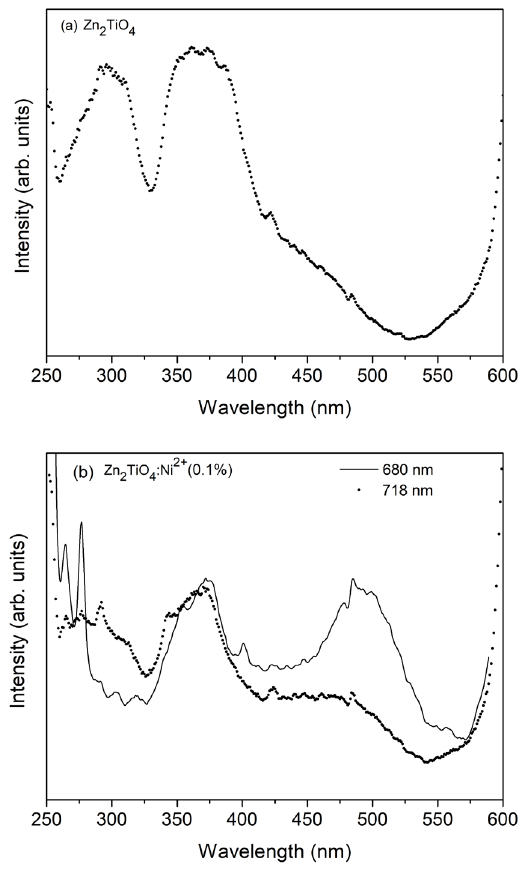
TiO 2 4 TiO :Ni 2+ (0.1% of Ni 2+ ) 2 4